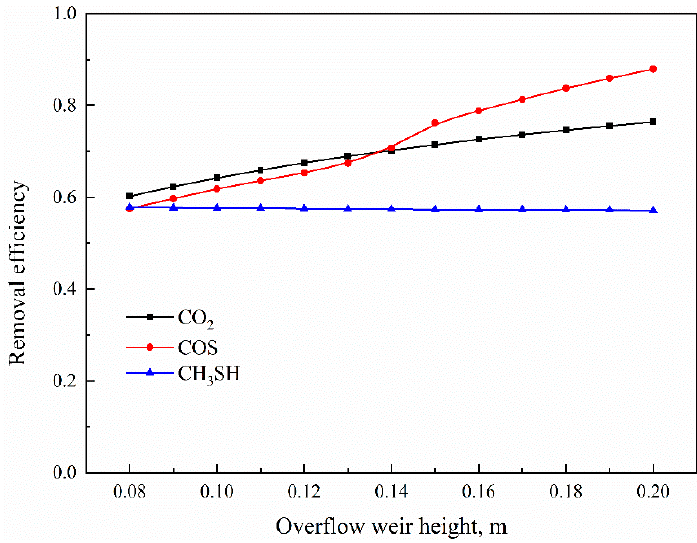
Figure 13. The effect of overflow weir height on removal efficiency (number of plates: 25; absorption pressure: 6 Mpa; inlet gas flow rate: 5.0 × 10 6 Nm 3 /d; inlet gas–liquid ratio: 600; inlet gas loading: CO 2 , 4.5 vol.%; H 2 S, 1.5 vol.%; COS, 15 mg/m 3 ; CH 3 SH, 15 mg/m 3 ).